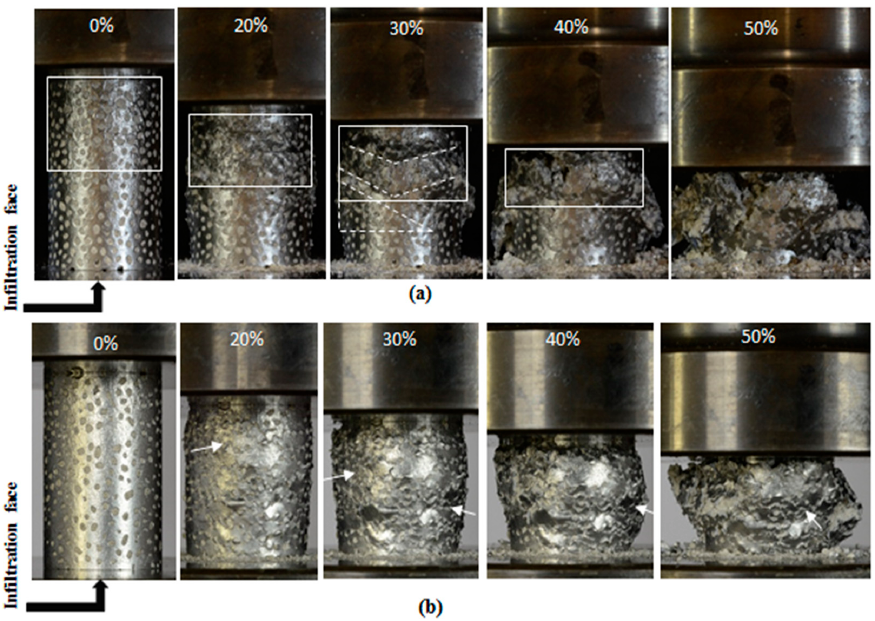
Figure 9. Compressive deformation mechanism of EG/A356 syntactic foam: ( a ) StEG-MSF4; and ( b ) ShEG-MSF3.